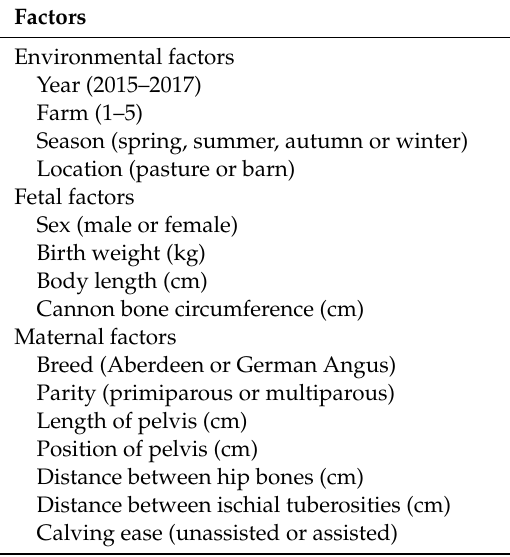
TableA1. Factorsconsideredtobepotentiallyvaluablepredictorsfordystociaand /